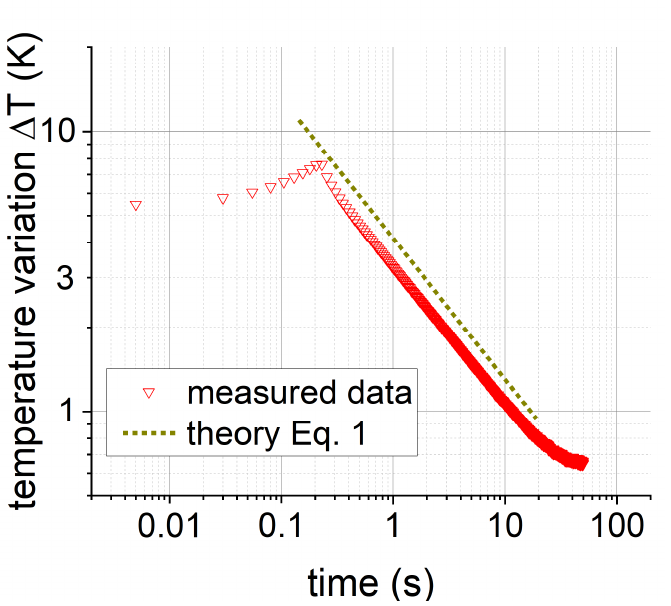
Figure 11. Same dataset same dataset as in Figure 10 but as a log–log plot to enable a comparison with Equation (1).